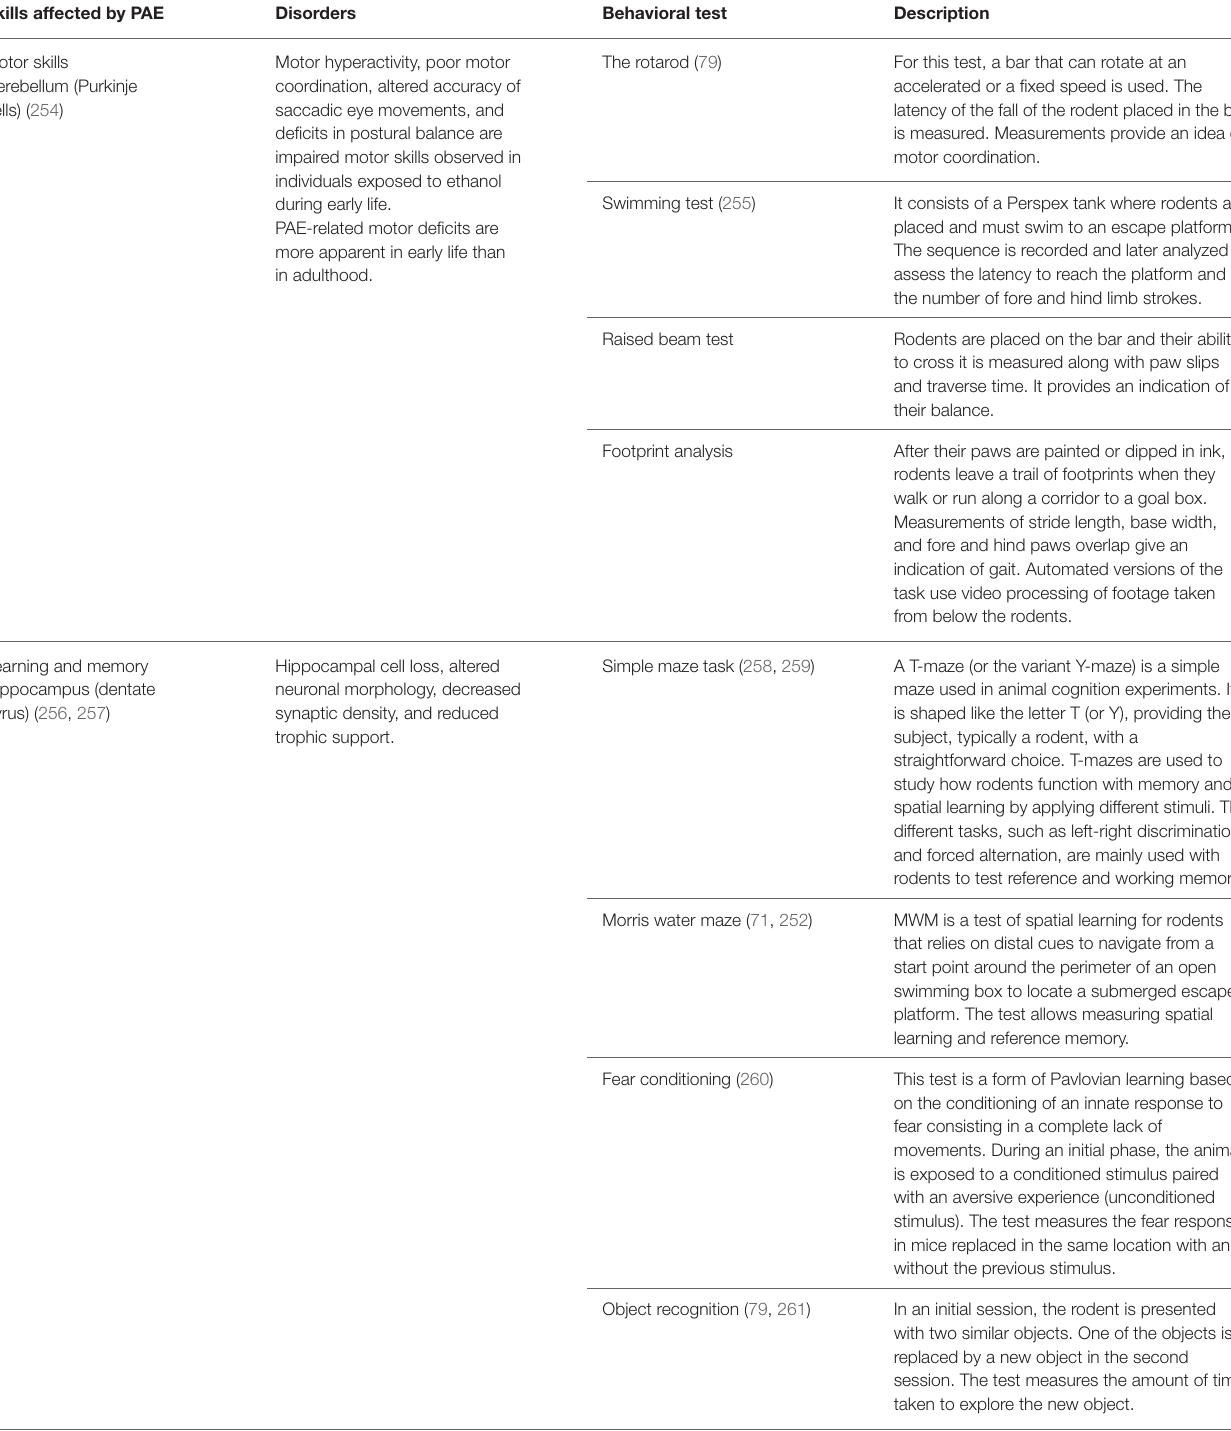
TABLE 2 | Standardized experimental methodologies for assessing behavioral effects of prenatal alcohol exposure in murine